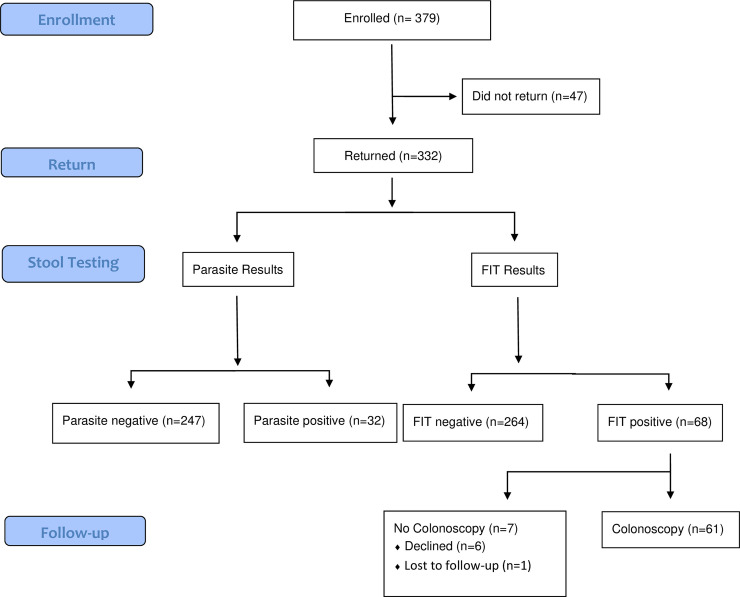
CONSORT flow diagram.